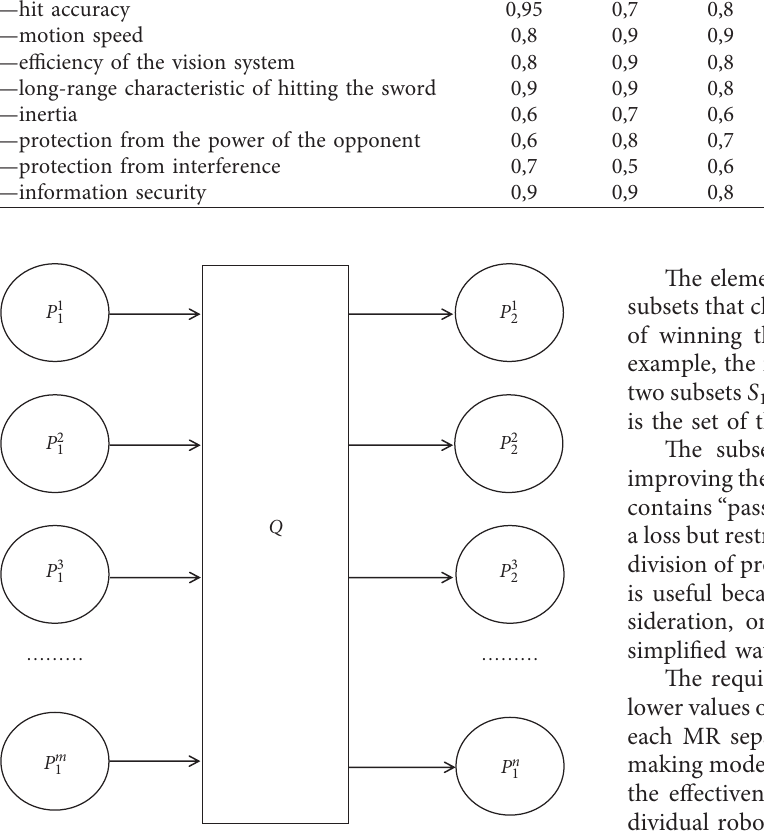
Figure 1: Initial plan for the assignment